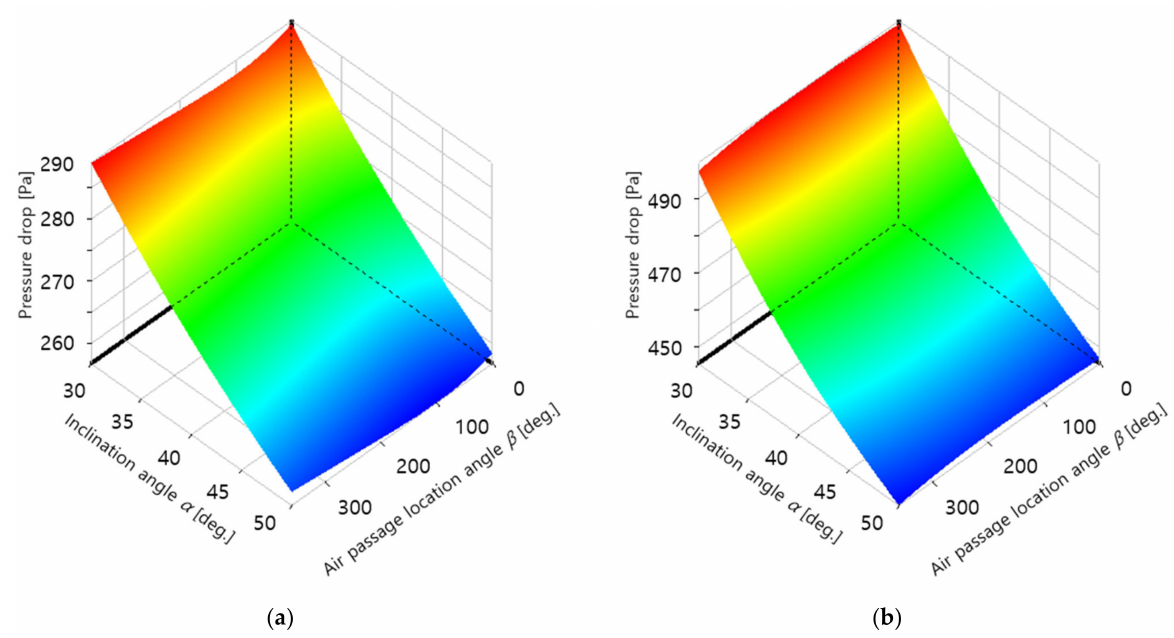
Figure 11. Response surfaces of pressure drop ∆ p in intake system according to change in design variables α and β : ( a ) 4500 rpm and ( b ) 6000